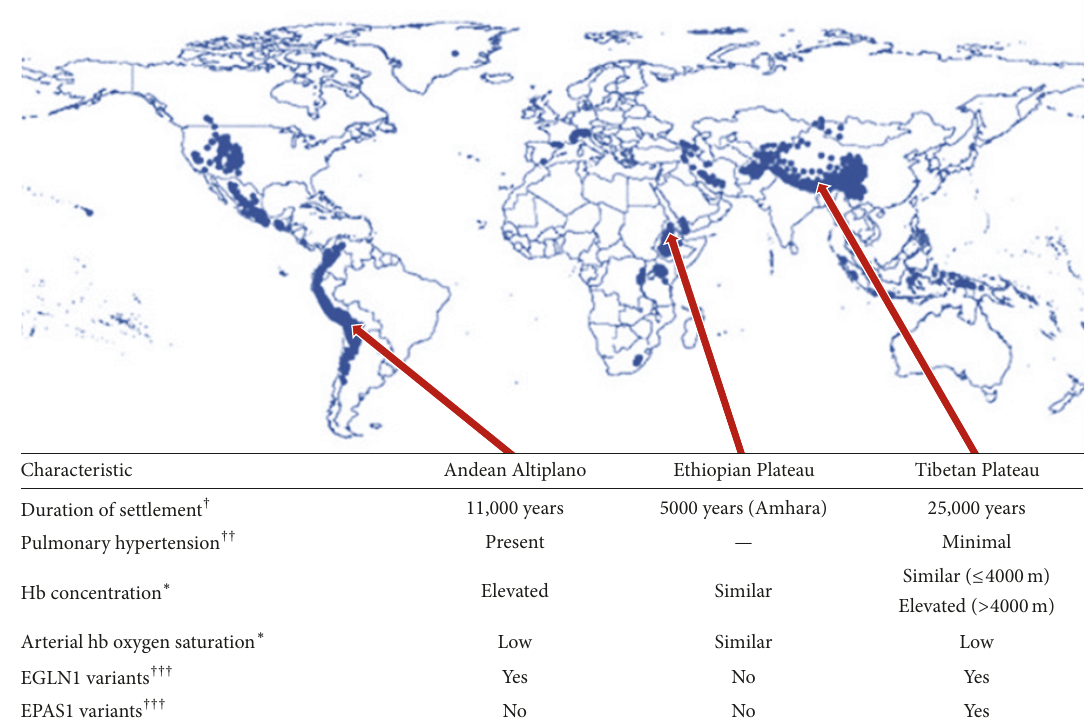
Figure 2: Map showing populated regions at altitudes of 2500 m or higher (from [17], permission granted), and characteristics of three major high-altitude populations. ∗ Compared with sea-level populations at low altitude (see [18, 19]). EGLN1: hypoxia-inducible factor prolyl 4-hydroxylase 2; EPAS1: hypoxia-inducible factor-2 훼 ; hb: hemoglobin. † : [20, 21], †† : [22–24], ††† :